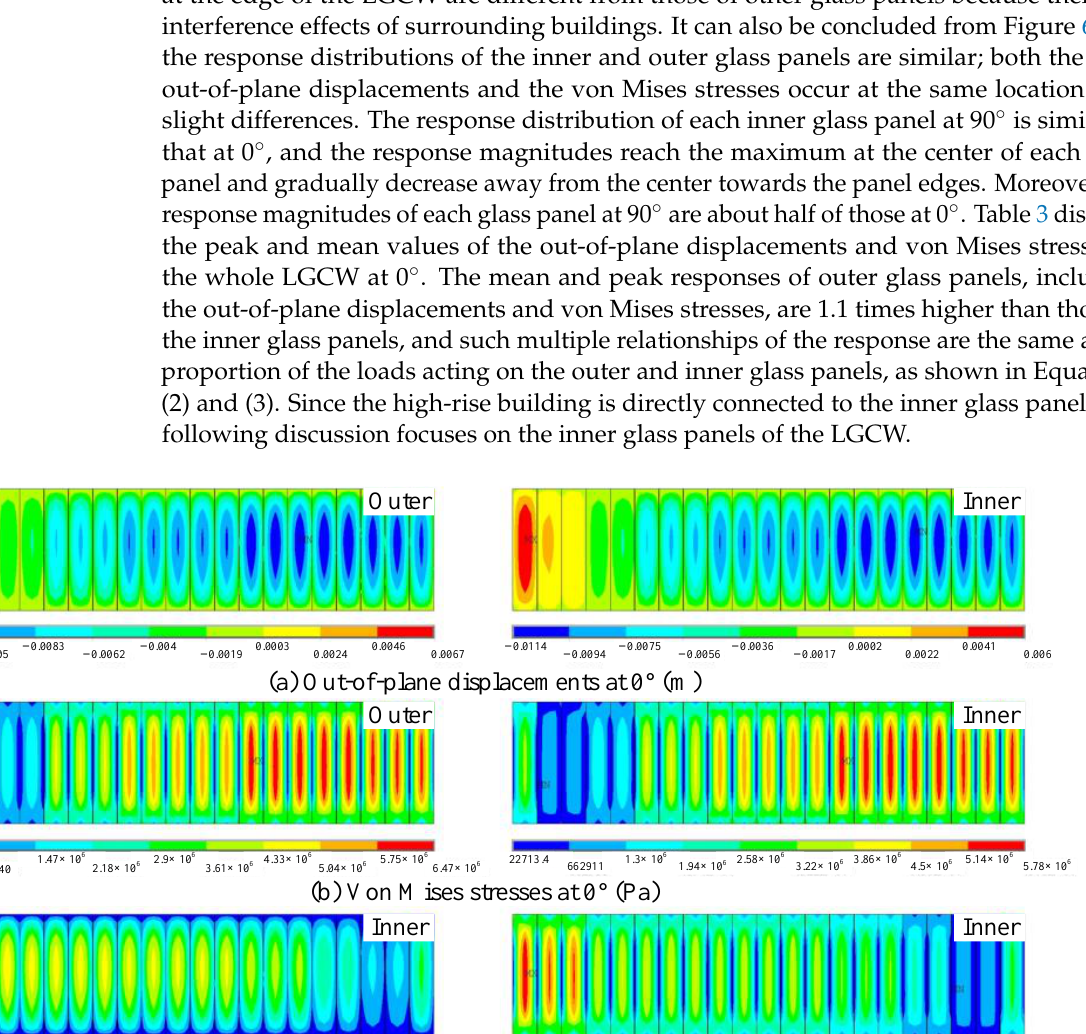
Table 3. Statistical response values of glass panels at 0°.